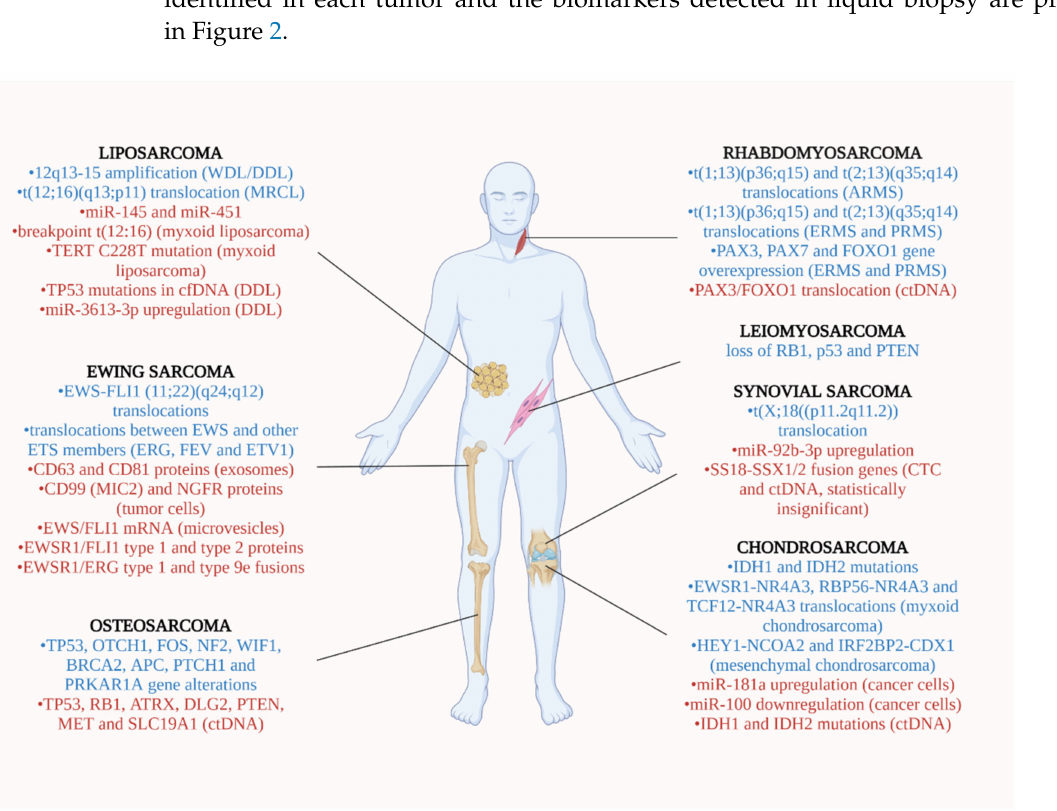
Figure 2. Soft tissue and bone sarcomas’ most common locations. Blue fonts: genetic alterations identified in each tumor type. Red fonts: Biomarkers detected for each tumor in liquid biopsy (Created with BioRender.com, accessed on 21 October